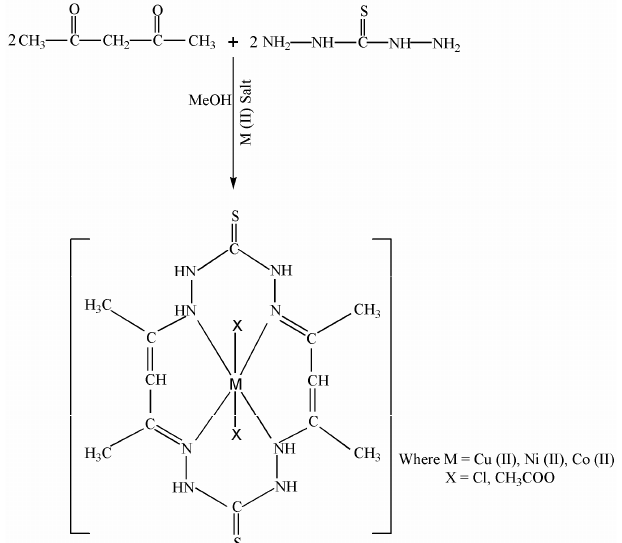
Figure 1 . Scheme for synthesis of novel macrocycles metal